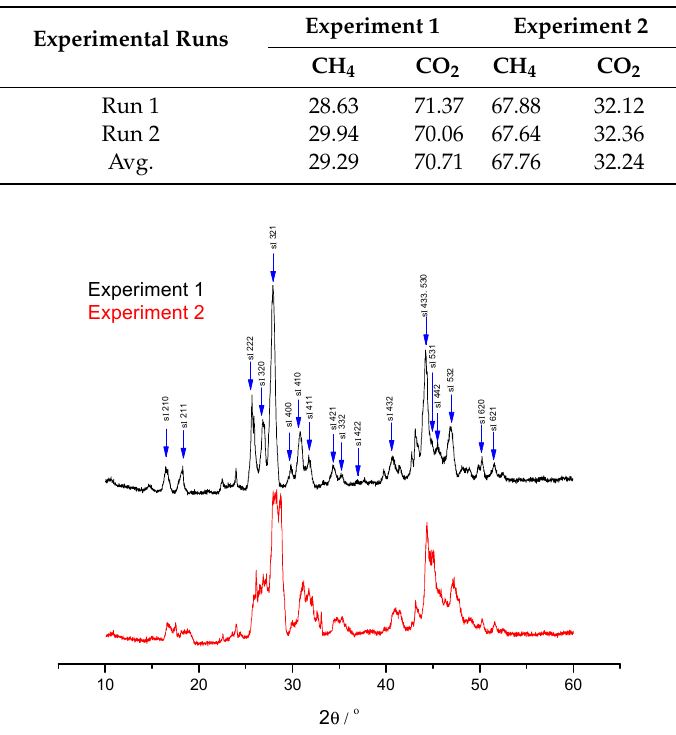
Figure 8. The PXRD pattern of gas hydrate phase after replacement process of experiment 1 and experiment 2. Table 2. Gas compositions in the dissociated gases after the completion of replacements for experiment 1 and experiment 2.